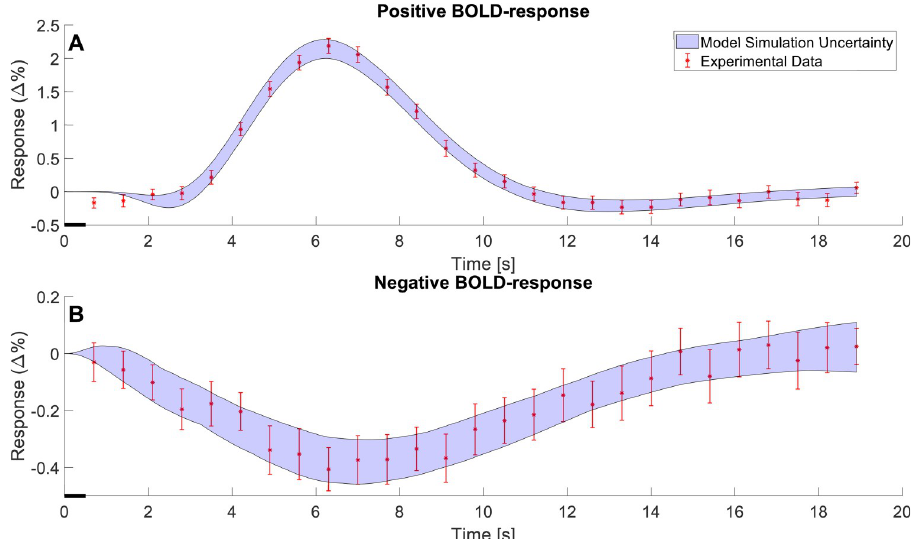
Fig 3. The model estimation of the BOLD response. A. The model estimation (blue shaded area) of the positive BOLD response fitted to data (red error bars) to a 0.5 second stimulus. B. The model estimation (blue shaded area) of the negative BOLD response fitted to data (red error bars) to a 0.5 second stimulus. The data is shown as mean values ± SEM and is taken from Sten et al. [23].